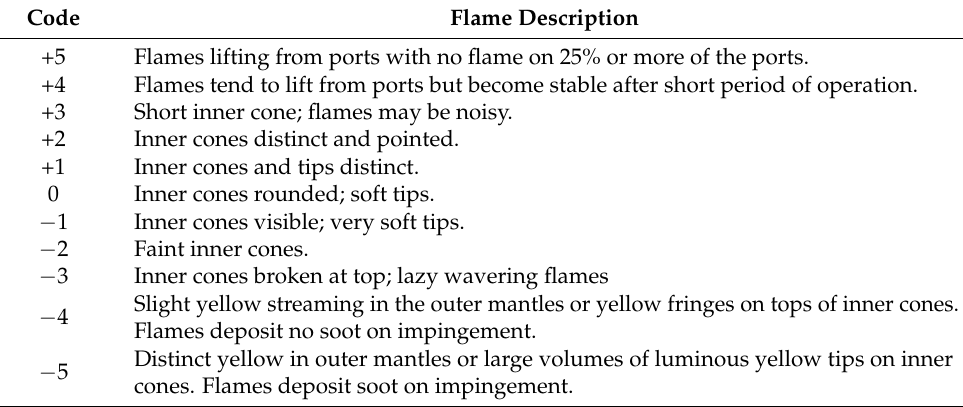
Table 13. AGA flame code classifications. Code Flame